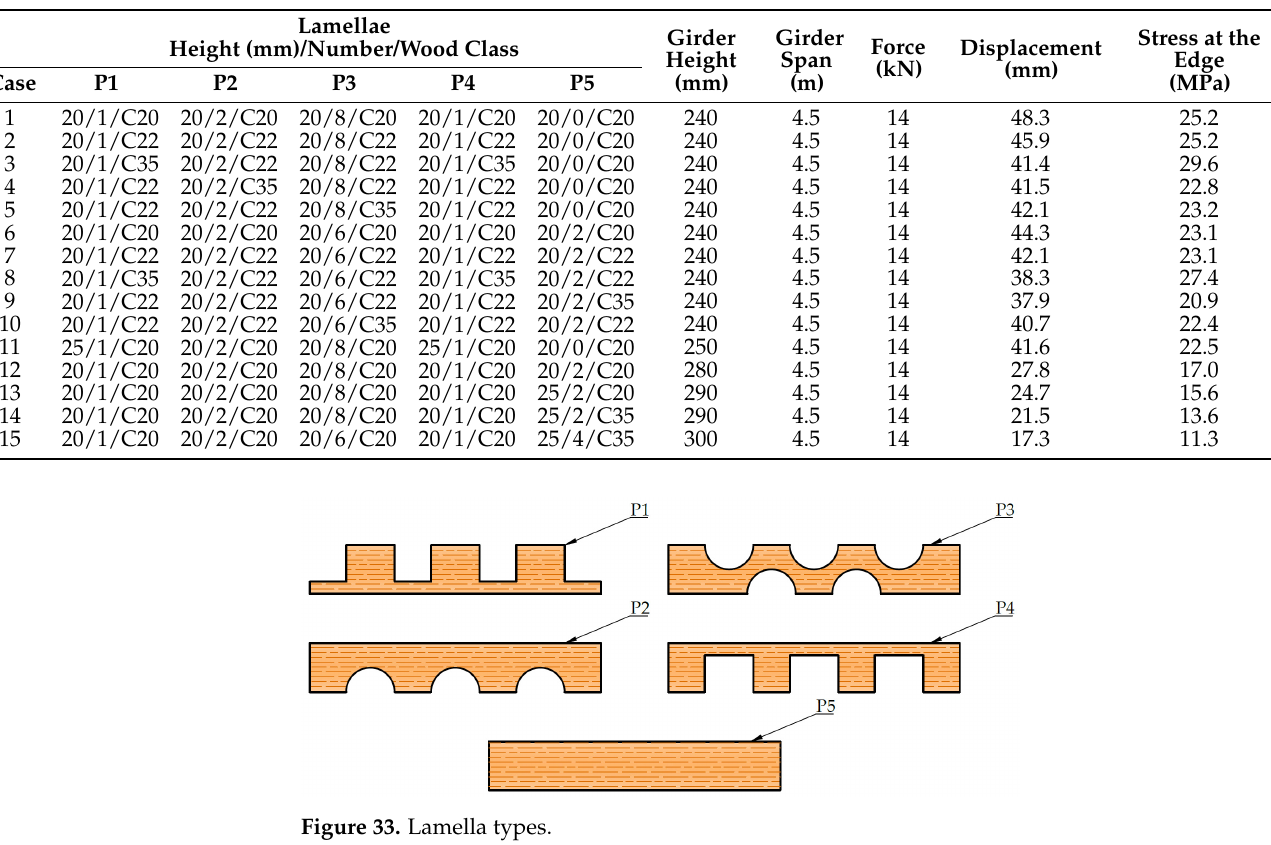
Table 5. Possibilities of combining different timber classes and lamellae.